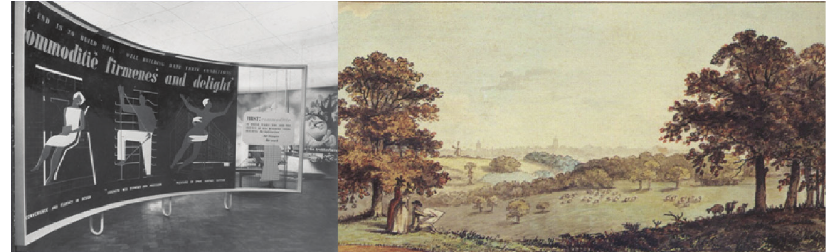
Figure 1. Cullen, exhibition panel, 1938–9. Source : Cullen personal archive (left). Repton, early watercolor illustration, “Catton Park” with Norwich in the distance, 1788 (right). Source : Norfolk Museums